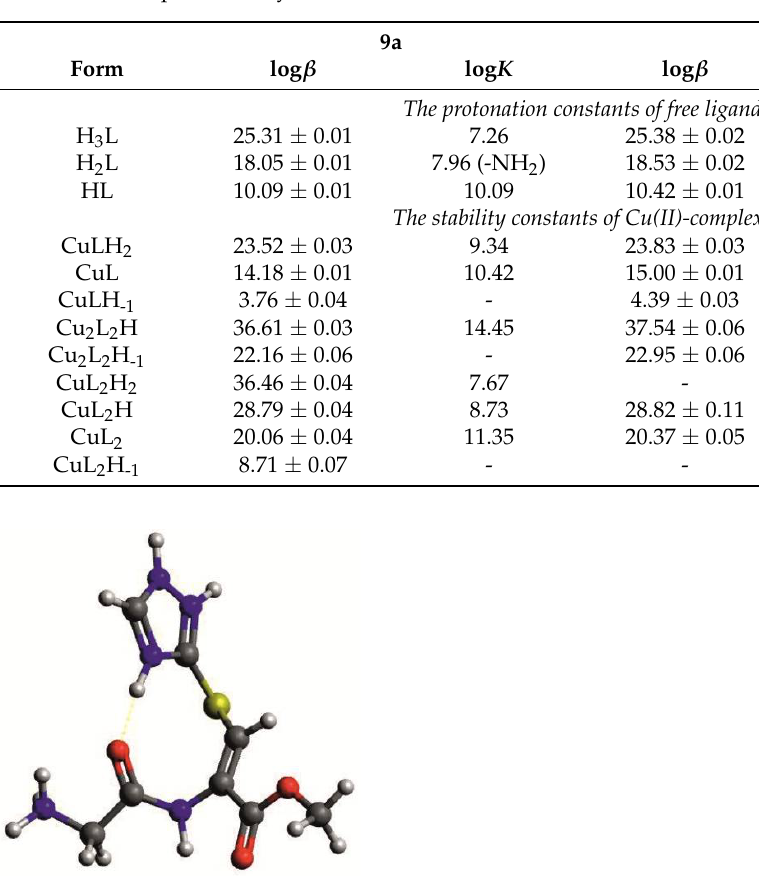
Table 2. The protonation constants of free ligands and stability constants of formed Cu(II)-complexes. The errors are represented by ± SD.